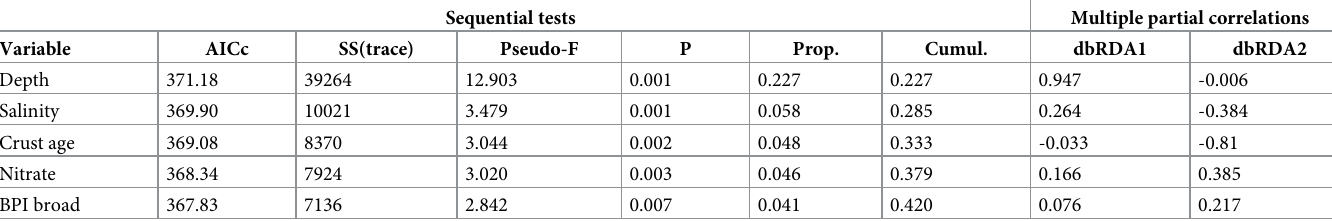
Multiple partial correlations are the relationships between dbRDA coordinate axes and orthonormal X variables. Prop. = proportion of variation explained. Cumul. = cumulative proportion variation